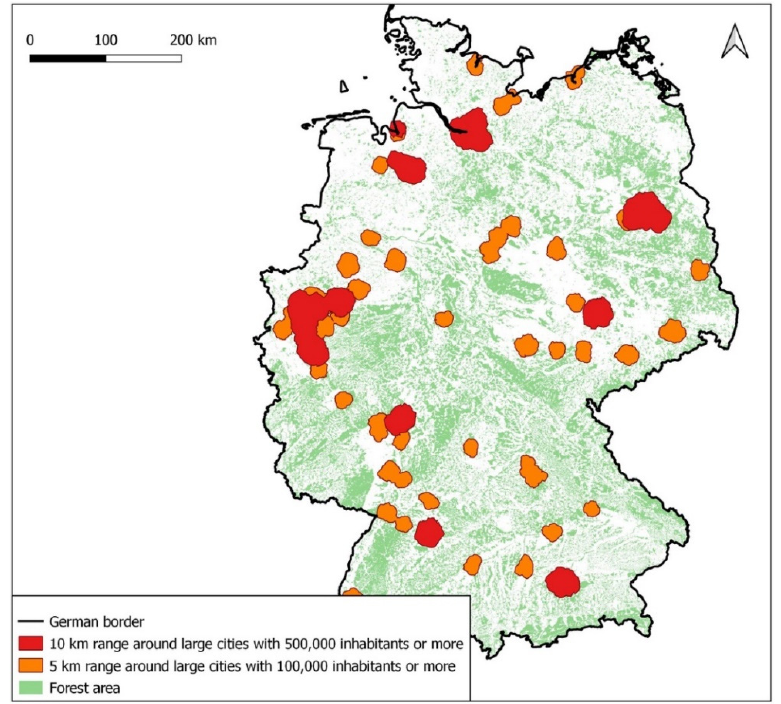
Figure 6. Forest areas in Germany outside of the largest cities exposed to risk of attack.